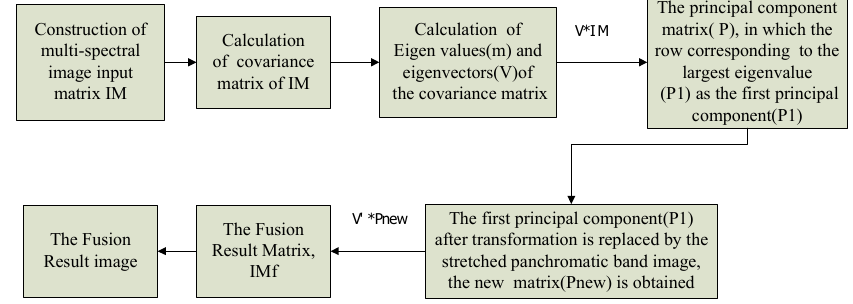
Figure 1. The flow chart about the serial fusion method of multi-spectral image and panchromatic image Based on principal component analysis